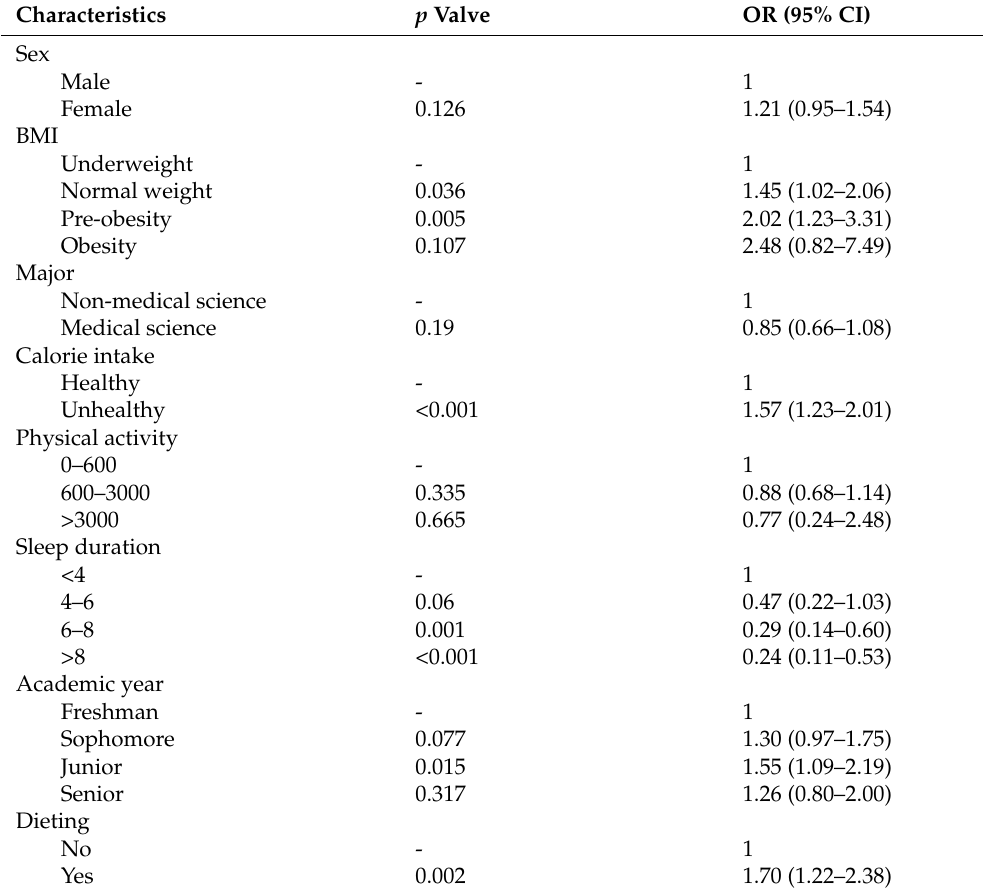
Table 4. Results of univariate logistic regression analysis of anxiety.